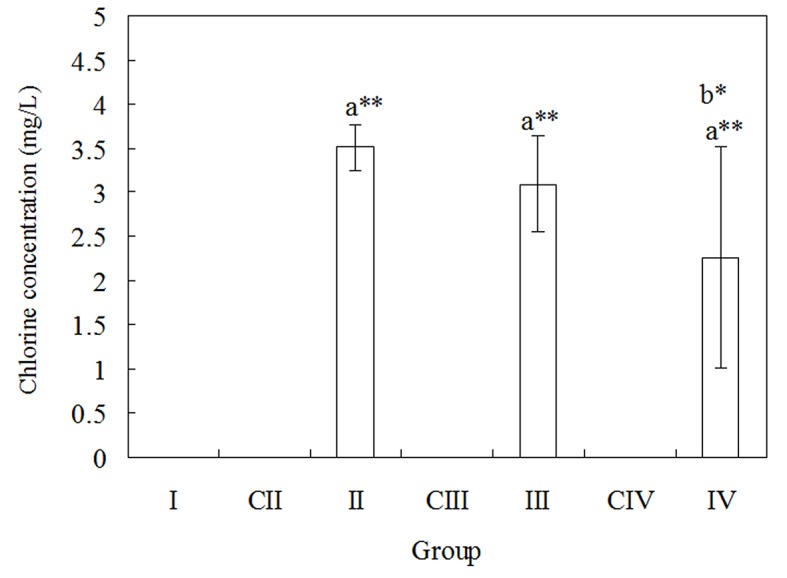
Dechlorination effects of Aroclor 1254 by Anabaena PD-1 cells.The result was presented as the mean values of quadruplicate experiments (**P<0.01, *P<0.05; ‘a’ indicates group II, III, IV vs. the control group I; ‘b’ indicates group III, IV vs. group II).